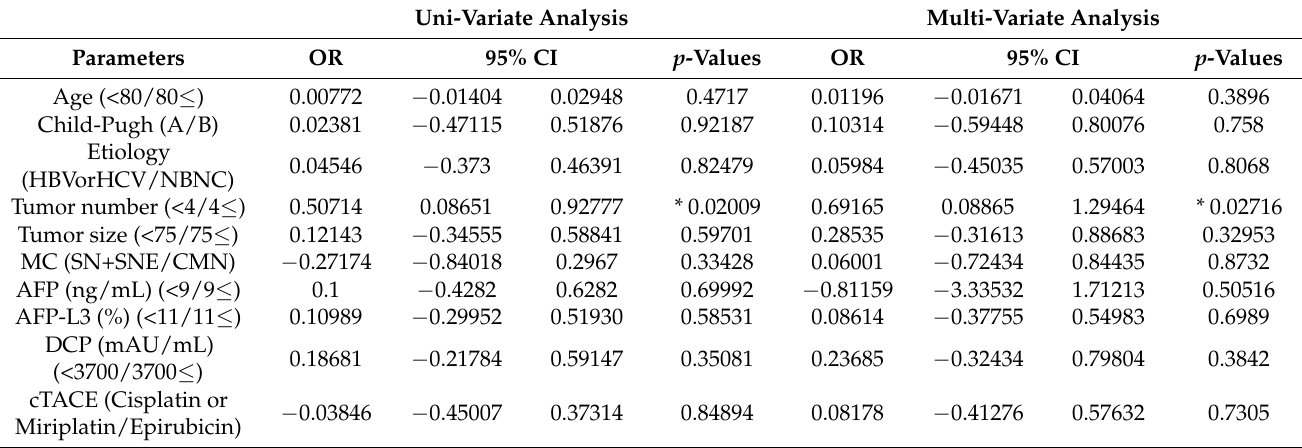
Table 4. Factors contributing to CR by DEB-TACE following cTACE (CR vs. non-CR). Uni-Variate